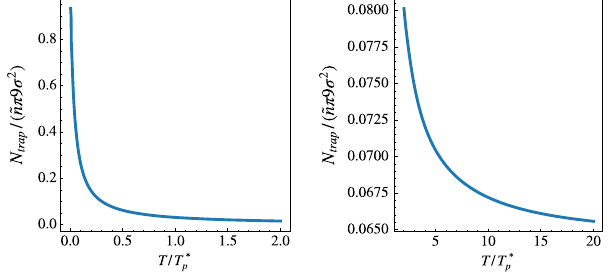
FIG. 14. Fraction of EDM molecules trapped in the beam as a function of T=T (cid:3) p , for T from 0 to 2 T (cid:3) p (left) and through 20 T (cid:3) p (right). For this calculation we considered trapping inside a radius of R b ¼ 3 σ , with σ the rms beam